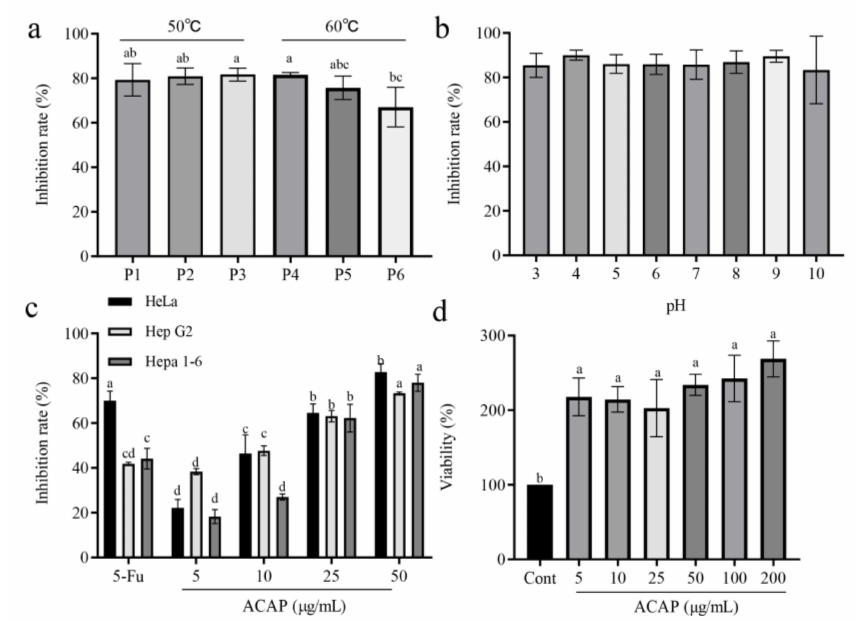
Figure 3. In vitro activity assays of ACAP: ( a ) In vitro antitumor activity assay at the concentration of 50 µ g/mL at 50 and 60 ◦ C; ( b ) in vitro antitumor activities of ACAP (50 µ g/mL) at pH 3–10; ( c ) inhibitory effects of ACAP on three tumor cell lines at indicated concentrations. 5-Fu: Positive control; ( d ) antiproliferative effect of ACAP on RAW264.7 cells. P1–P3: Protein fractions treated at 50 ◦ C for 30, 60, 120 min; P4–P6: Protein fractions treated at 60 ◦ C for 30, 60, 120 min. Cont: Normal control; ACAP: Treatment with ACAP at concentrations 5, 10, 25, and 50 µ g/mL. 5-Fu: Positive control (50 µ g/mL). Differing letters above bars indicate significant ( p < 0.05) differences according to Tukey’s multiple comparisons